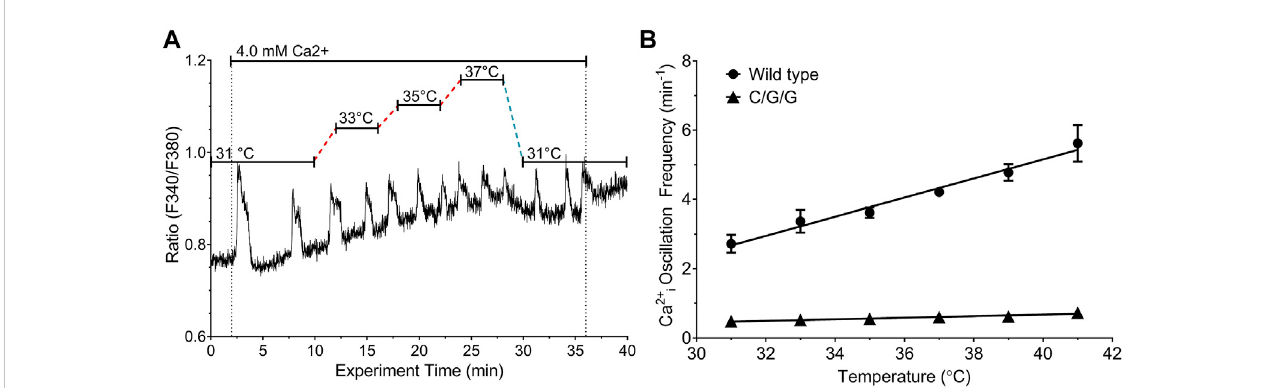
FIGURE 4 Effect of temperature on Ca 2+ o -induced Ca 2+ i frequency in HEK-293 cells transfected with CaSR/mGluR1/mGluR1 chimeras. HEK-293 cells that stably expressedCaSR/mGluR1/mGluR1chimericreceptors(HEK-C/G/Gcells) orcontrol HEK-CaSR cellswere loadedwith fura-2 AM andthen exposed to 4.0 mM Ca 2+ o as described in Materials and Methods. The temperature was adjusted as required in the range 31 ° C – 37 ° C. (A) Representative single cell Ca 2+ i response to 4.0 mM Ca 2+ o in the range 31 ° C – 37 ° C in HEK-C/G/G cells. (B) Linear relationships between temperature and Ca 2+ i frequency for HEK-CaSR (circles) and HEK-C/G/G cells (triangles) at 4.0 mM Ca 2+ o ; several error bars are contained within the data points.